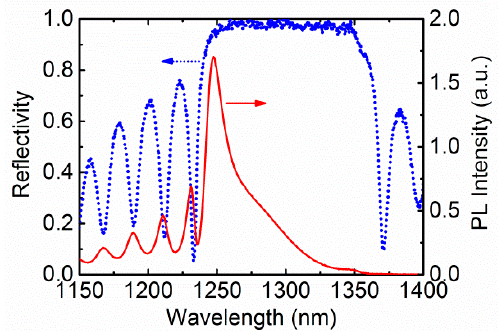
Figure 3. Measured photo-luminescence (PL) and reflectivity spectra of QD sample without top DBR.